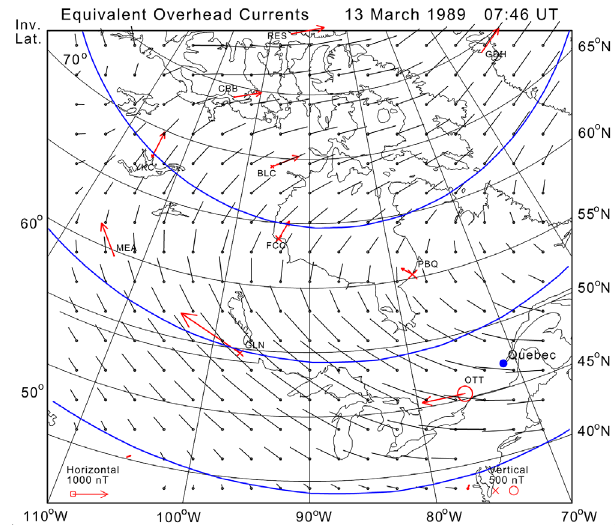
Fig. 8. Whirl of overhead ionospheric currents over eastern Canada on 13 March 1989 at 07:46 UT in the format of Figure